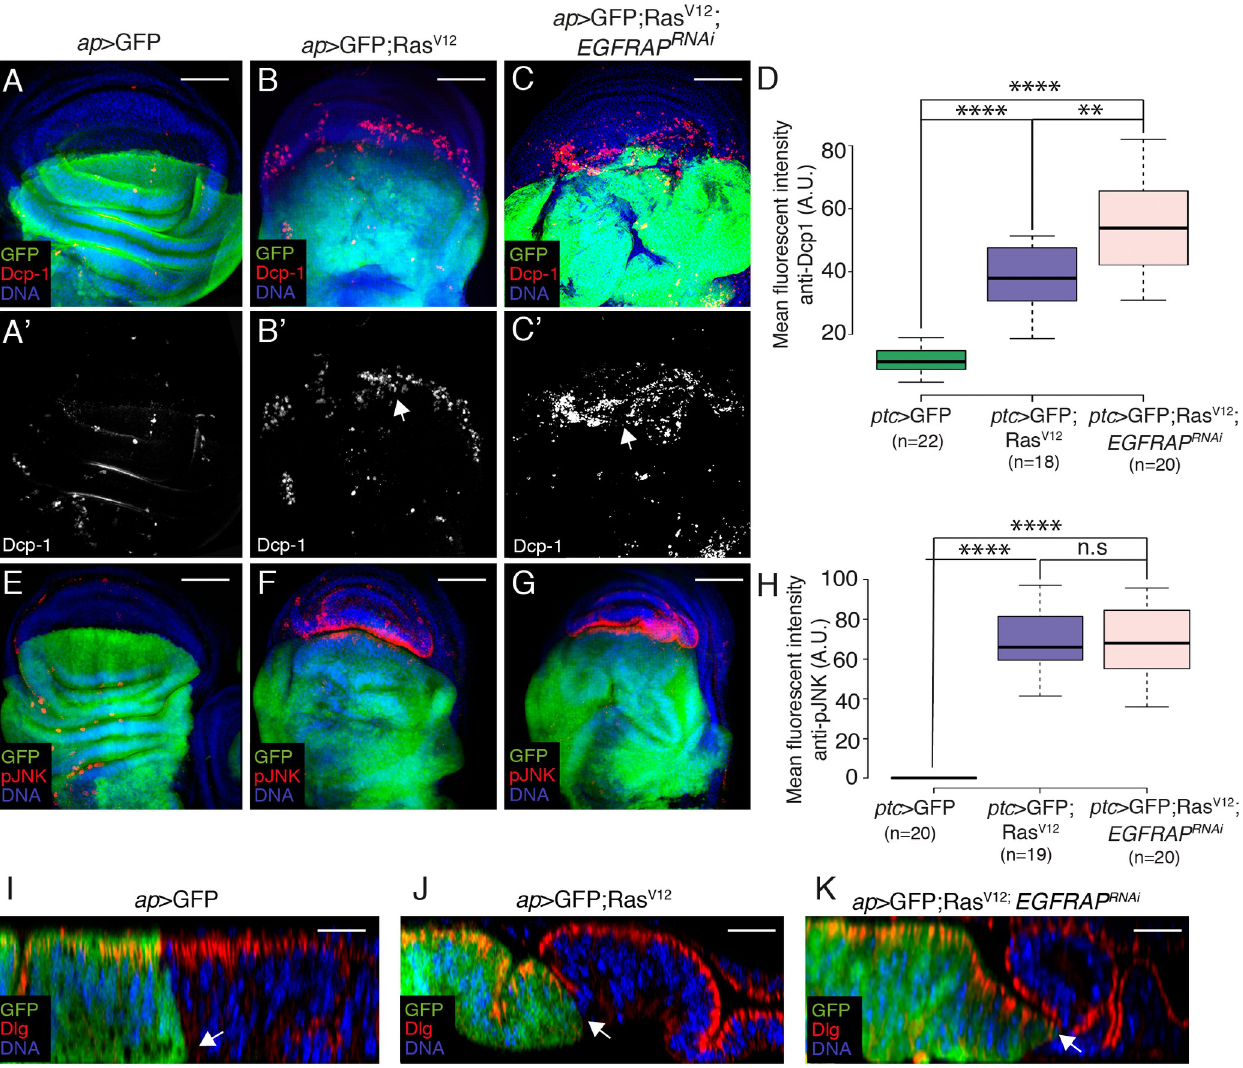
Fig 3. EGFRAP downregulation increases apoptosis and JNK activity in wild-type cells adjacent to Ras V12 expressing cells. (A-G) Maximal projection of confocal views of wing imaginal discs from third-instar larvae expressing GFP (green) and the indicated UAS transgenes under the control of ap -Gal4, stained with anti-GFP (green), anti-Dcp-1 (red in A-C, white in A’-C’), anti-pJNK (red in E-G) and Hoechst (DNA, blue). (D, H) Box plots of mean fluorescent Dcp-1 (D) and pJNK (H) intensities of wing discs of the designated genotypes. (I-K) Confocal yz sections parallel to the A/P axis of wing imaginal discs from third-instar larvae expressing GFP (green) and the indicated UAS transgenes under the control of ap -Gal4, stained with anti-GFP (green), anti- Dlg (red) and Hoechst (DNA, blue). Apical side of wing discs is to the top. Arrows in I-K point to the border between dorsal experimental and ventral control cells. The statistical significance of differences was assessed with a t-test, ���� and ��� P values < 0.0001 and < 0.001, respectively. Scale bars, 50 μ m (A-G) and 30 μ m